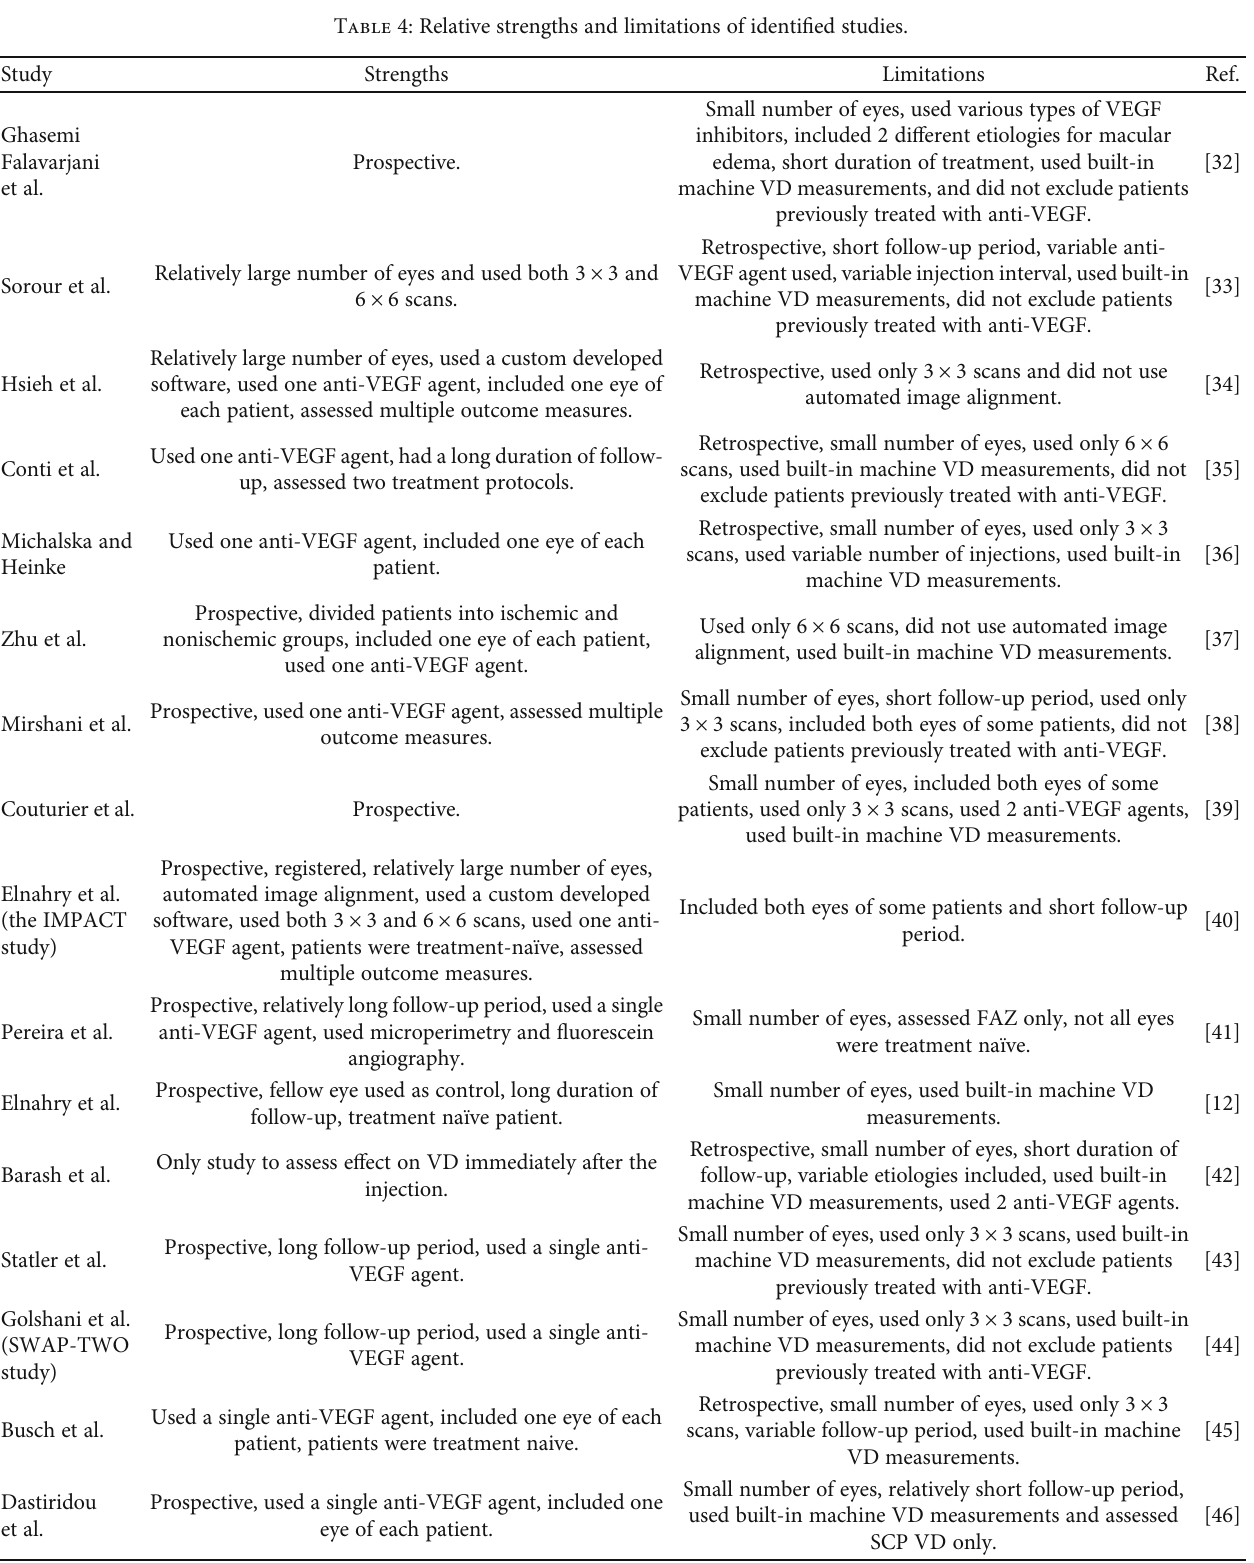
Table 4: Relative strengths and limitations of identi fi ed